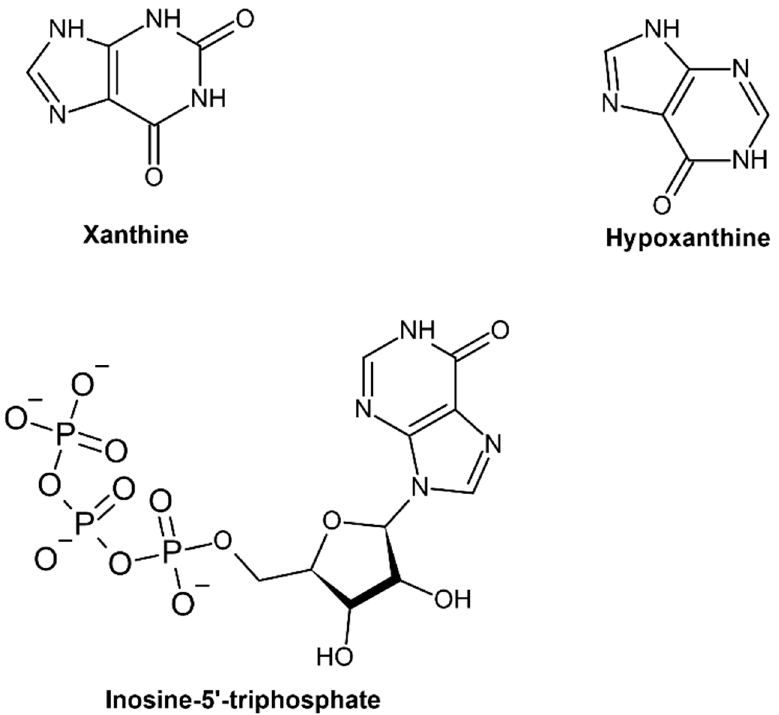
Figure 4. Chemical structure of contributing molecules for the ITP cycle, namely xanthine, hypoxanthine and inosine 5-triphosphate.